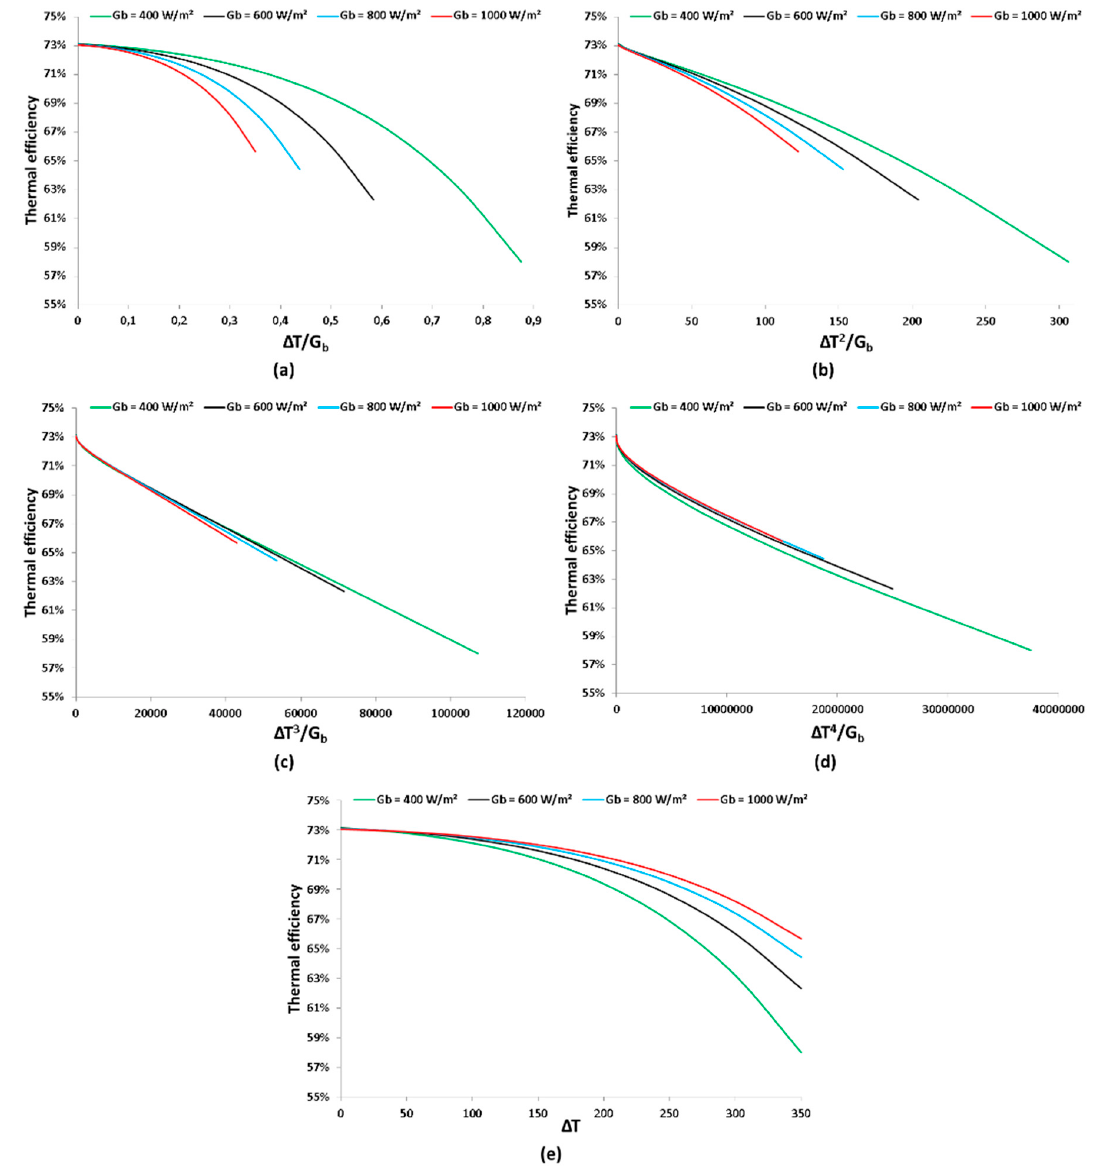
Figure 2. Thermal e ffi ciency as a function of di ff erent parameters: ( a ) ∆ T / G b , ( b ) ∆ T 2 / G b , ( c ) ∆ T 3 / G b , Figure 2. Thermal efficiency as a function of different parameters: ( a ) ΔΤ / G b , ( b ) ΔΤ 2 / G b , ( c ) ΔΤ 3 / G b , ( d ) ∆ T 4 / G b , ( e ) ∆ T ( d ) ΔΤ 4 / G b , ( e ) ΔΤ .